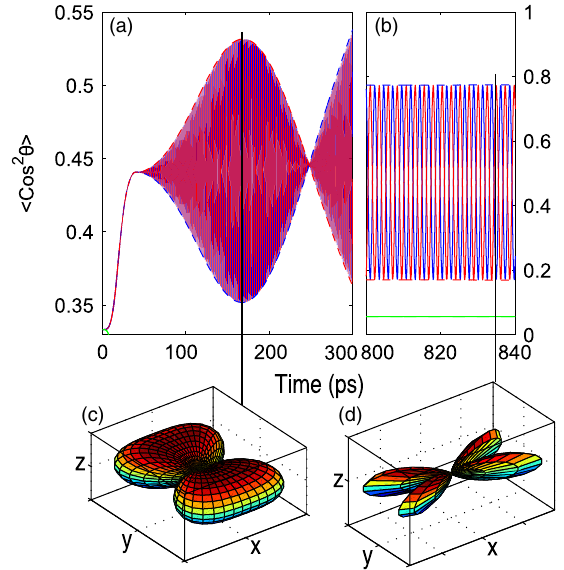
ffiffiffiffiffiffiffiffiffiffiffiffiffiffiffiffiffiffiffiffiffiffiffiffi q q ffiffiffiffiffiffiffi (cid:2) (cid:4) j E 1 ð t Þjj E 2 ð t Þj U ¼ . (a) (cid:1) ¼ 1 : 5 B 2 I (cid:1) 2 I (cid:1) 2 . In both plots, (cid:3) 1 ¼ 40 ps , (cid:3) 2 ¼ 800 ps @